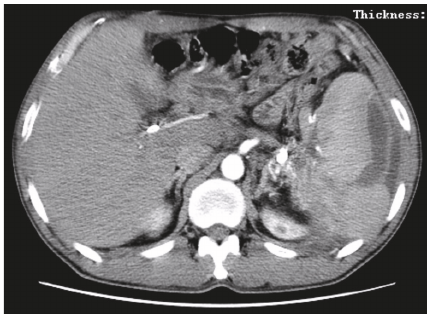
Figure 8: CT scan showing the volume of splenic subcapsular hematoma significantly reduced compared to all previous